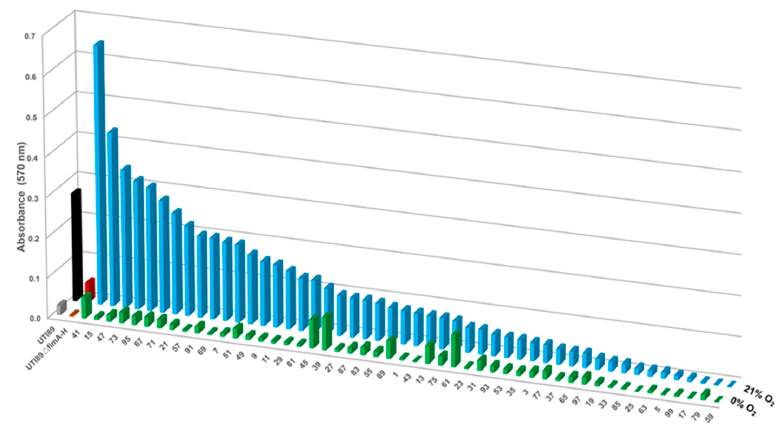
under anoxic conditions independent of type 1 pili production. Graph depicting the quantified biomass for 50 urine-associated E. coli strains collected from the urine of patients at VUMC. These randomly-selected isolates were seeded in standard biofilm plates and allowed to develop biofilms along the wall of the wells for 48 h in ambient oxygen conditions. The Z-axis depicts the oxygen concentration under which the isolates were grown. Urine-associated E. coli isolates are graphed from the highest biofilm production to lowest under 21% oxygen (blue bars). UTI89 (black bars) and the isogenic UTI89 ∆ fimA-H mutant (red bars) were used as controls for comparison of the assay. All isolates exhibited significantly-reduced biofilm compared to their own growth under ambient oxygen conditions, except isolates VUTI39 and VUTI61 (green bars). The average of a minimum of two independent experiments is shown, with a minimum of eight technical replicates per experiment. The standard error of the mean for each VUTI isolate is shown in Table